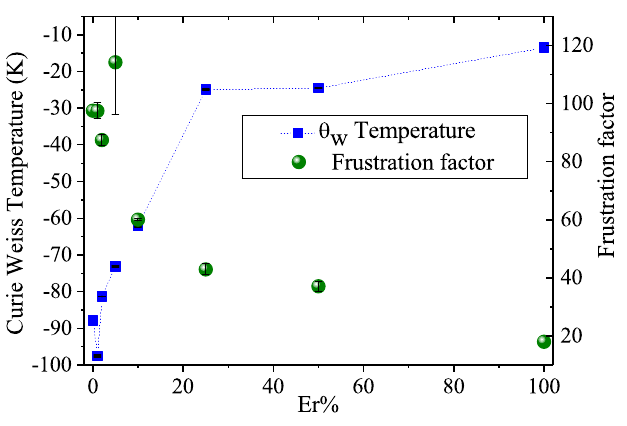
Figure 6. Curie–Weiss temperature and frustration factor as a function of Erbium content. Data for the SrYb 2 O 4 have been collected from [14] and, for SrEr 2 O 4 , have been collected from [18]. The low-temperature susceptibility data are shown in Figure 7. All samples present